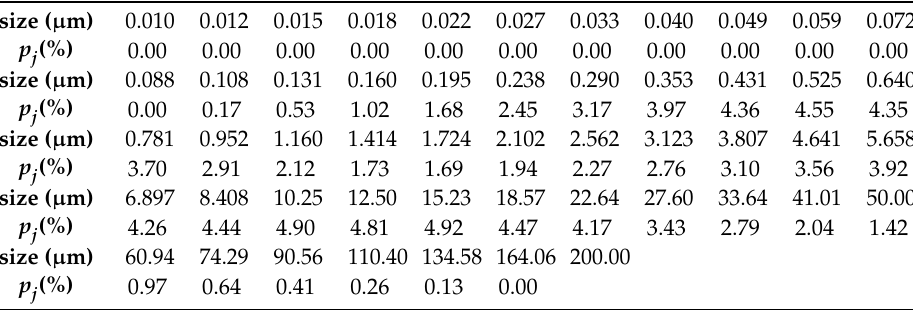
Table 1. Particle size distribution of the sediment sample in